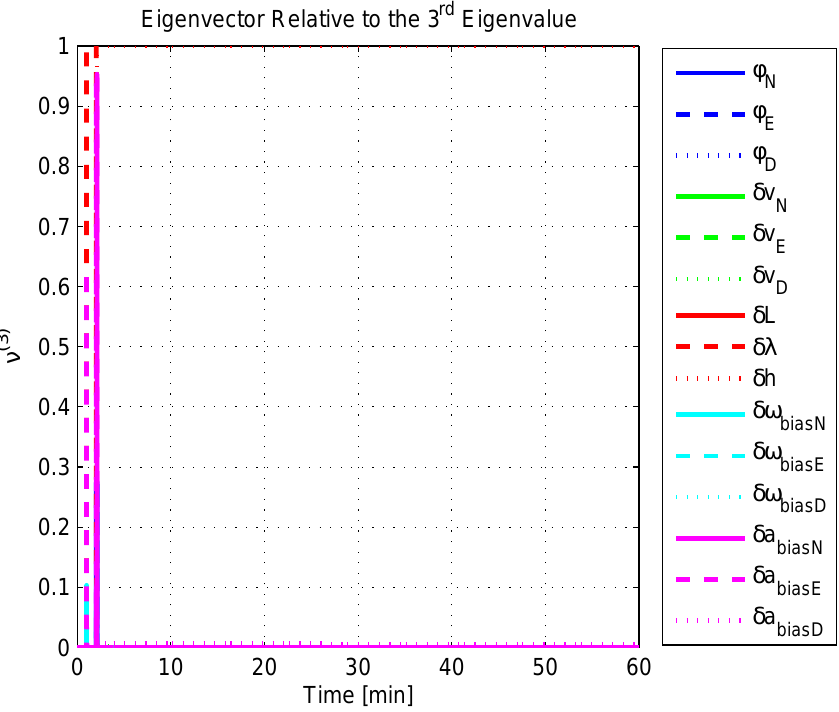
Figure 18. Eigenvector relative to the third eigenvalue in the experimental test.